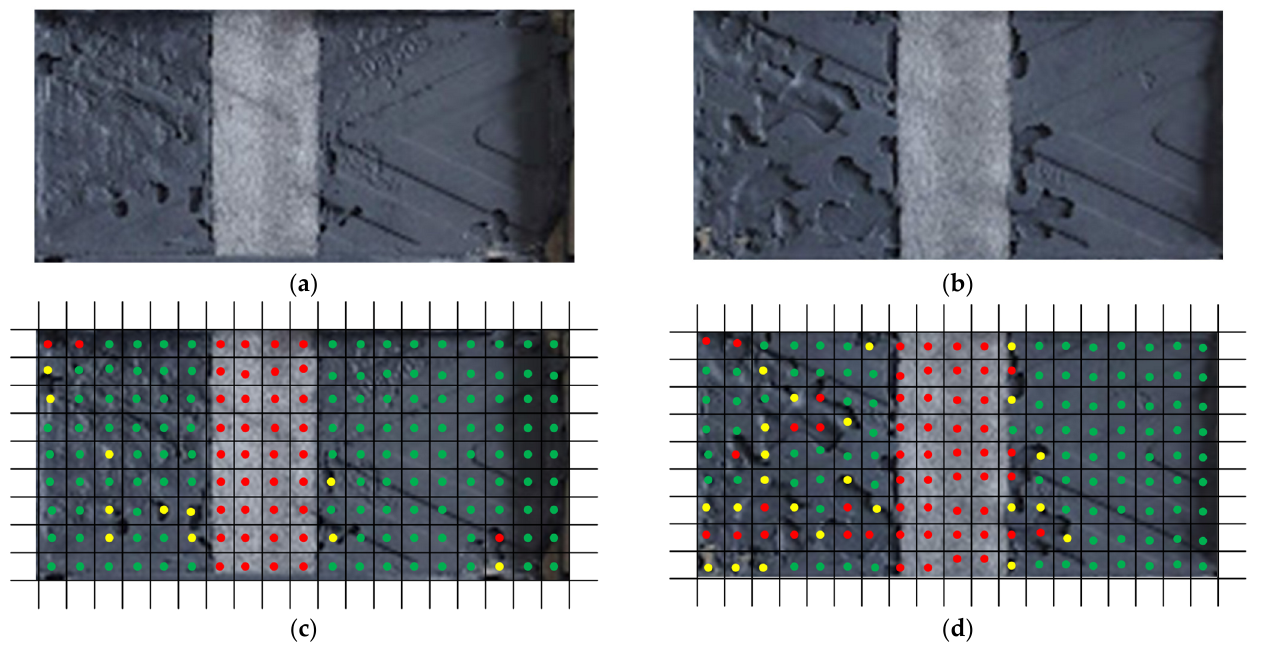
Figure 8. Visual results of bonding surface: ( a ) normal base; ( b ) hollow-type base; ( c ) normal base (visual evaluation overlaid); ( d ) hollow-type base (visual evaluation overlaid). The adhesion area ratio, determined by the microwave measurement, was compared with the visual result, as shown in Table 1. The differences in the adhesion area ratio were 4.1 percent points (pp) for the normal sample and 2.0 pp for the hollow-type sample. These results are satisfactory. The present system can contribute to practical applications. Table 1. Comparison of the adhesion rate between the fabricated system and visual inspection. Sample Type Adhesion Rate Evalu- ated from Microwave Measurement